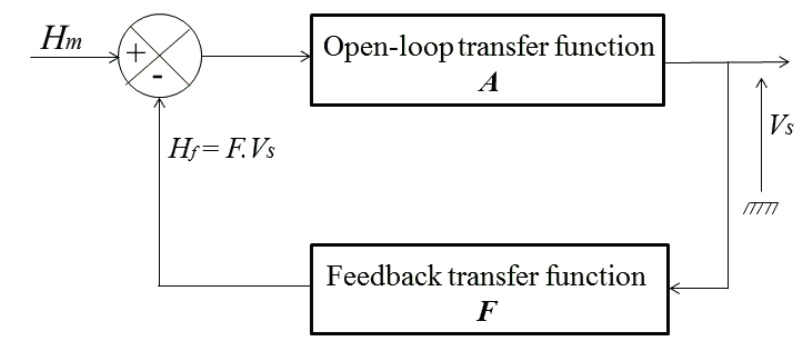
Figure 15. The functional diagram of the closed-loop of GMI